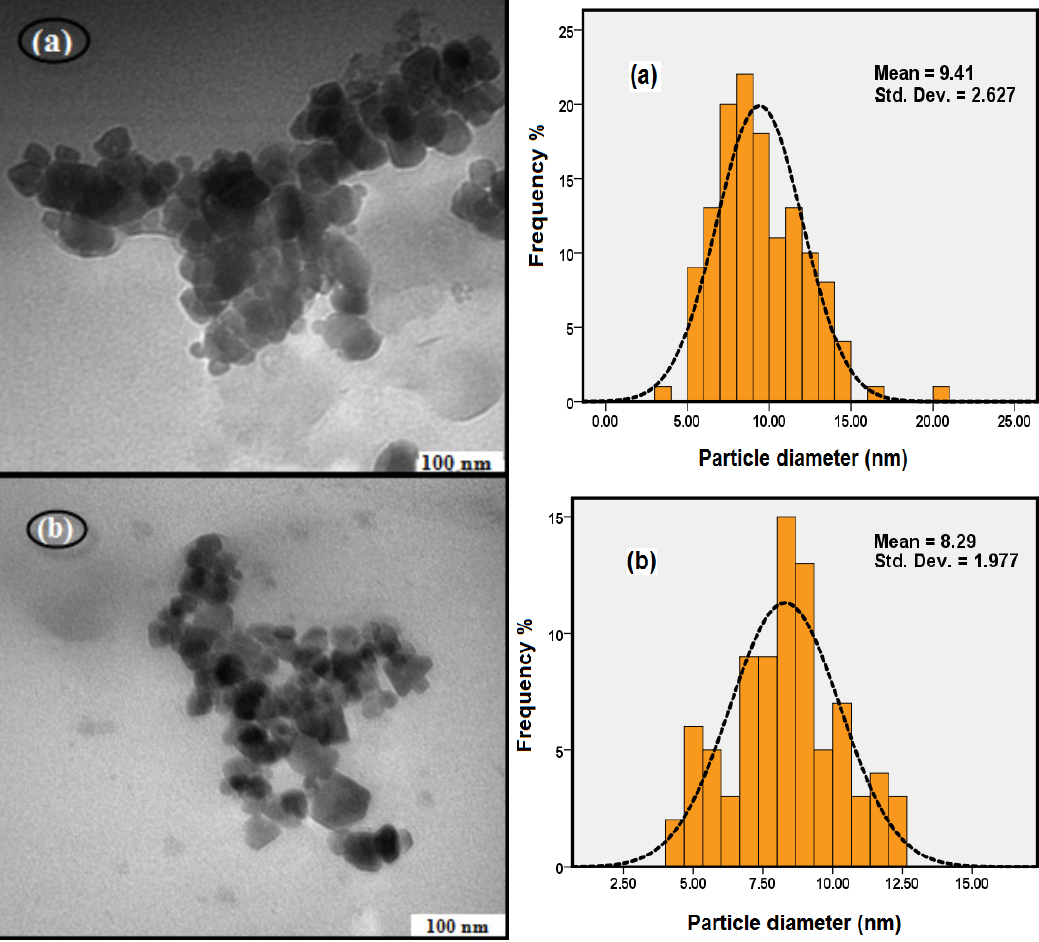
O MNPs at different Stirring rate; ( a ) 400 rpm, ( b ) 600 rpm, 3 4